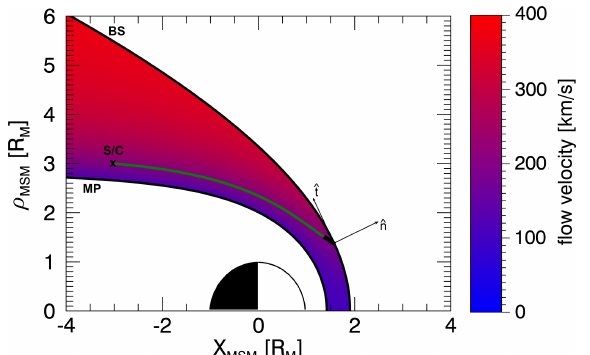
Figure 3. Color-coded flow speed calculated from Eq. (13) with the averaged upstream parameters from the Tao et al. (2005) solar wind propagation model at Mercury between 2011 and 2015. Also plotted is a schematic representation of back-traced flow line (green) from a virtual spacecraft (S/C) to the bow shock (BS) with the respective shock normal ˆ n and tangent ˆ t obtained from Eq. (12). The thick black line downstream of the BS is the downstream velocity vector direction determined by Eq. (13). Alfvén Mach number is 5 . 8, and plasma beta is 0 .